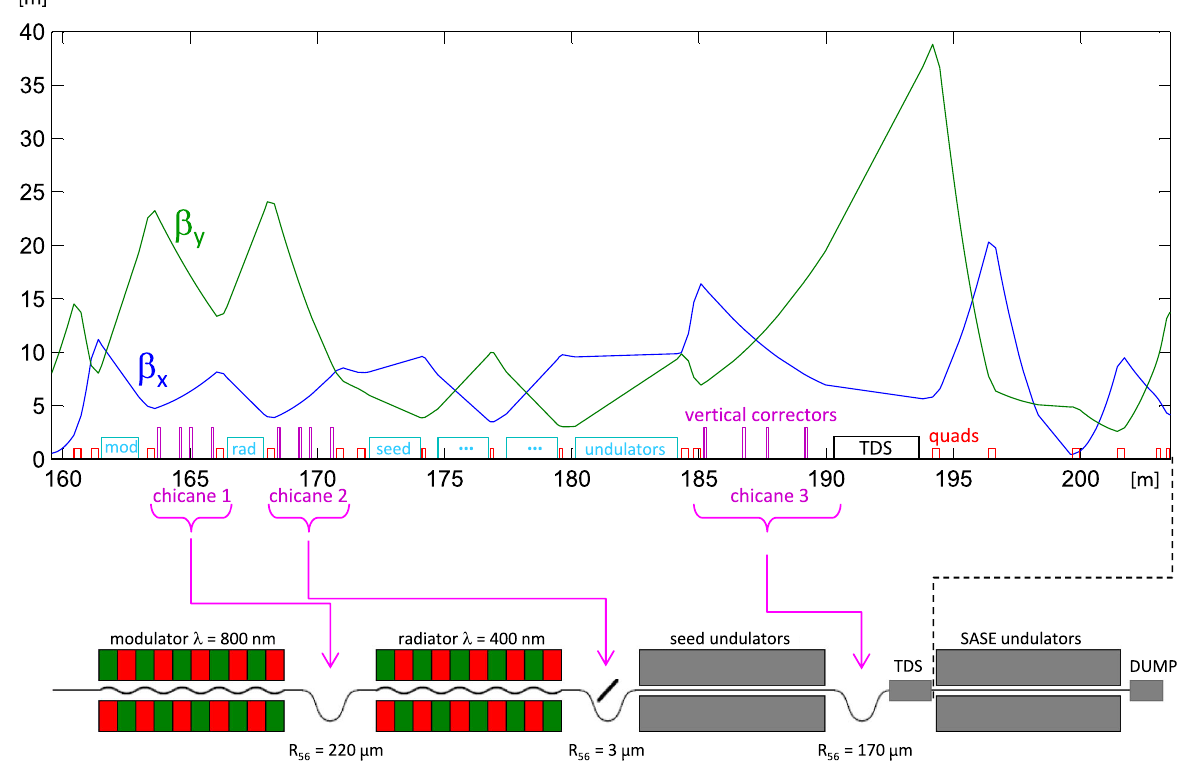
FIG. 7. Seeding section of FLASH: optical functions and layout.